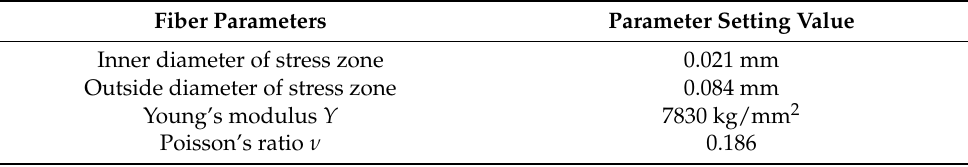
Table 1. Key parameters of the YOFC-PM-1310 80-18/135